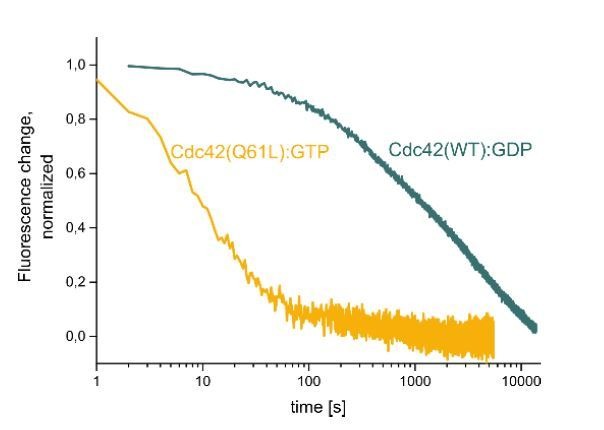
Dissociation of either GTP-loaded, Cy3-Cdc42 (Q61L) (yellow) or GDP-loaded Cy3-Cdc42 (WT) from Alexa647-RhoGDI after addition of excess unlabeled RhoGDI at t=0 as monitored by FRET..